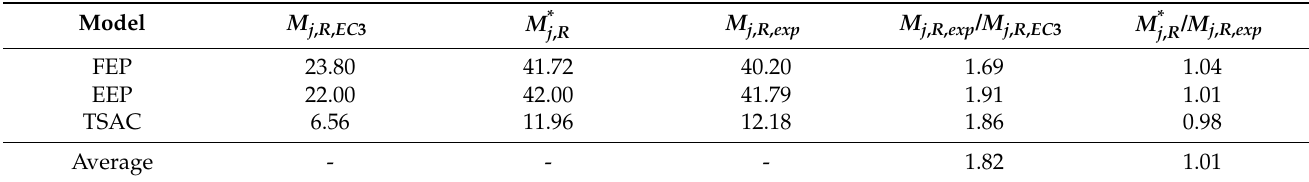
Table 2. Comparison of the plastic moment evaluated with EC3, M j , R , EC 3 , proposed method, M ∗ , and the method of Zanon and Zandonini [42] from the experimental curves, M j , R , exp , (Units: kNm).